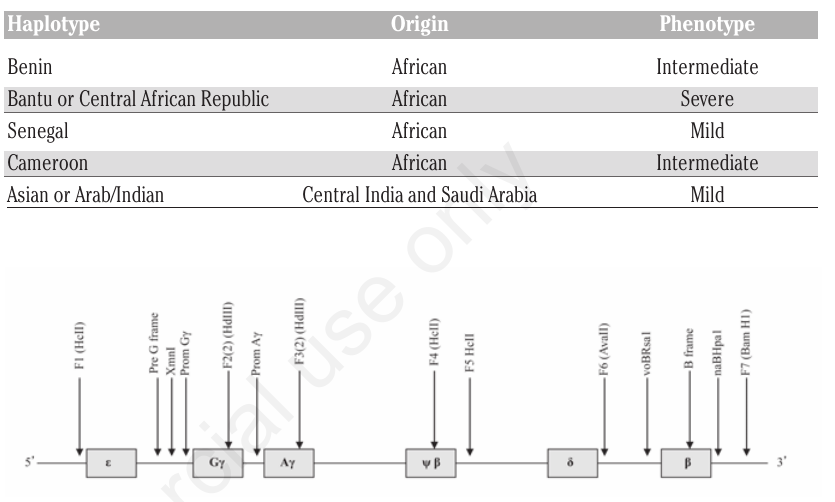
Figure 1. Schematic representation of the β -globin gene cluster. The arrows indicate the locations of the 13 different regions that contain the 47 serial of polymorphic sites (SNPs), including the 5 sites screened for the traditional haplotypes. The extra 42 SNPs are explained as follow: F1 contains 1 SNP in the 5’ region of the ε -gene. The preGframe in the 5’ region of the G g -gene contains 5 SNPs that are linked and only occur in a lim- ited number of combinations. The promoter regions of the g -genes; promG g and promA g contain 10 SNPs each, among which are the non-deletional HPFH point mutations. Also among the G g promoter is the Xmn-I site, which is known to cause continued expression of HbF during adult life in case of erythropoietic stress. F2, in intron 2 of the G g -gene, and F3, in intron 2 of the A g -gene both contain 4 SNPs. F4 contains 1 SNP in the pseudo β -gene. F5 contains 1 SNP in the 3’ region of the pseudo β -gene. F6 contains 1 SNP in the 3’ region of the δ -gene. The voBRsa1 fragment in the 5’ region of the β -gene contains 5 SNPs. This fragment also contains a very polymorphic (AT)xTy repeat located after SNP 1 that includes SNP 2. The β -frame in the β -gene contains 3 linked SNPs that only occur in a limited number of combinations. The naBHpa1 fragment in the 3’ region of the β - gene contains 1 SNP. F7 in the 3’ region of the β -gene contains 1 SNP. In addition, the XmnI site has also been indicated in the figure.